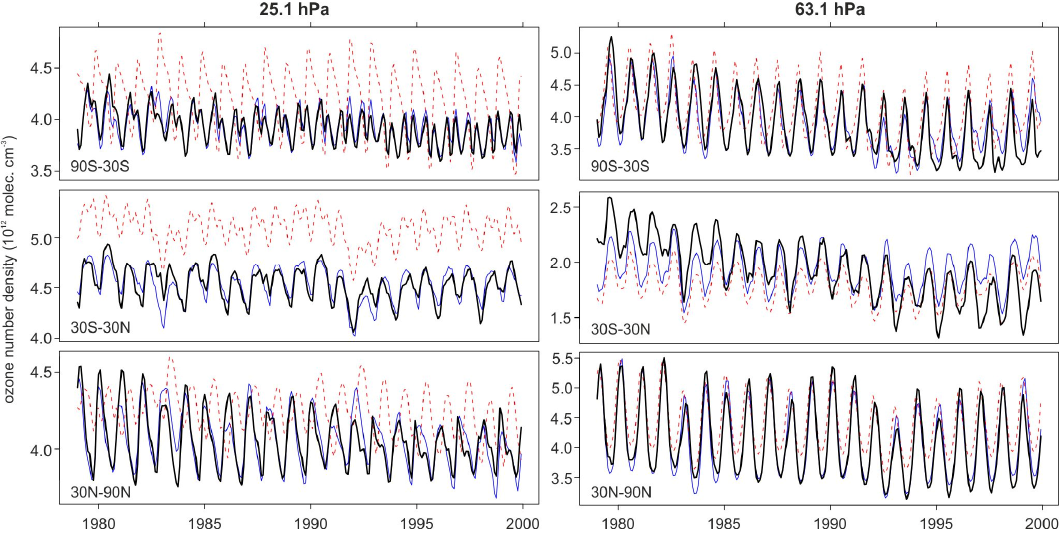
Fig. 3. Comparison of zonal mean ozone at two levels and in three latitude regions from the original SOCOL simulations (red dotted), debiased SOCOL simulations (blue) and BDBP (thick black).